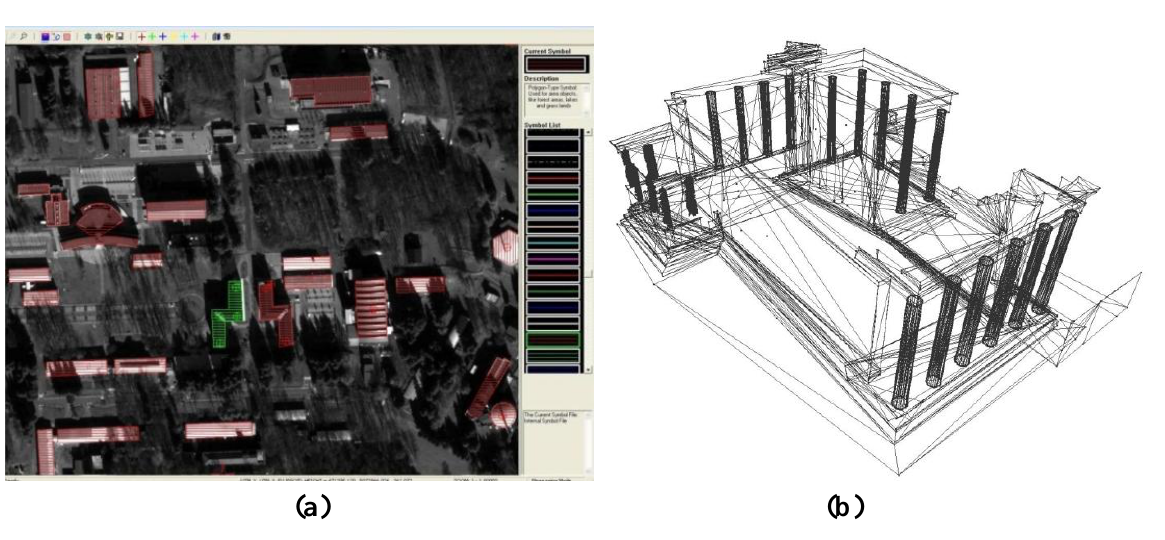
Figure 8. Extraction of man-made structures from satellite images (a) and reconstruction of complex architectural objects from terrestrial images (b) using interactive measurements in order to achieve accurate and detailed results.